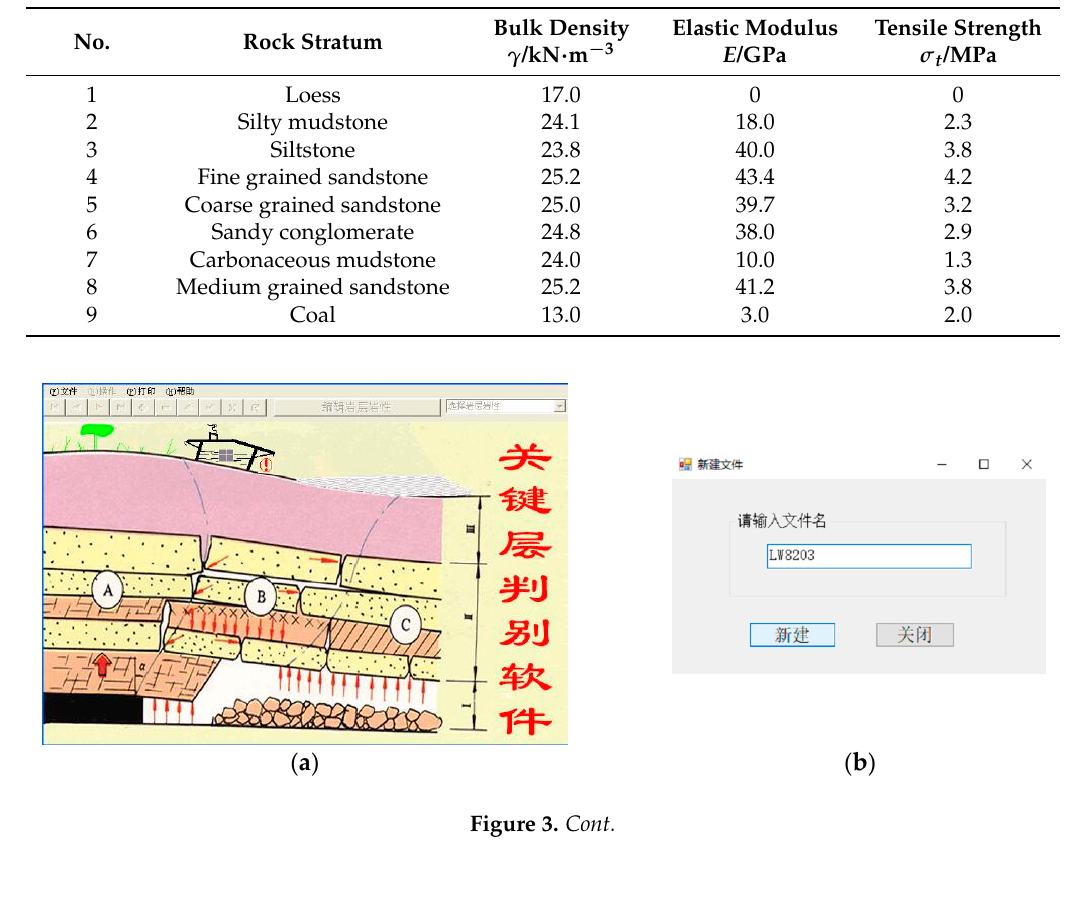
Table 1. Physico-mechanical properties of the overlying rock material of LW8203.